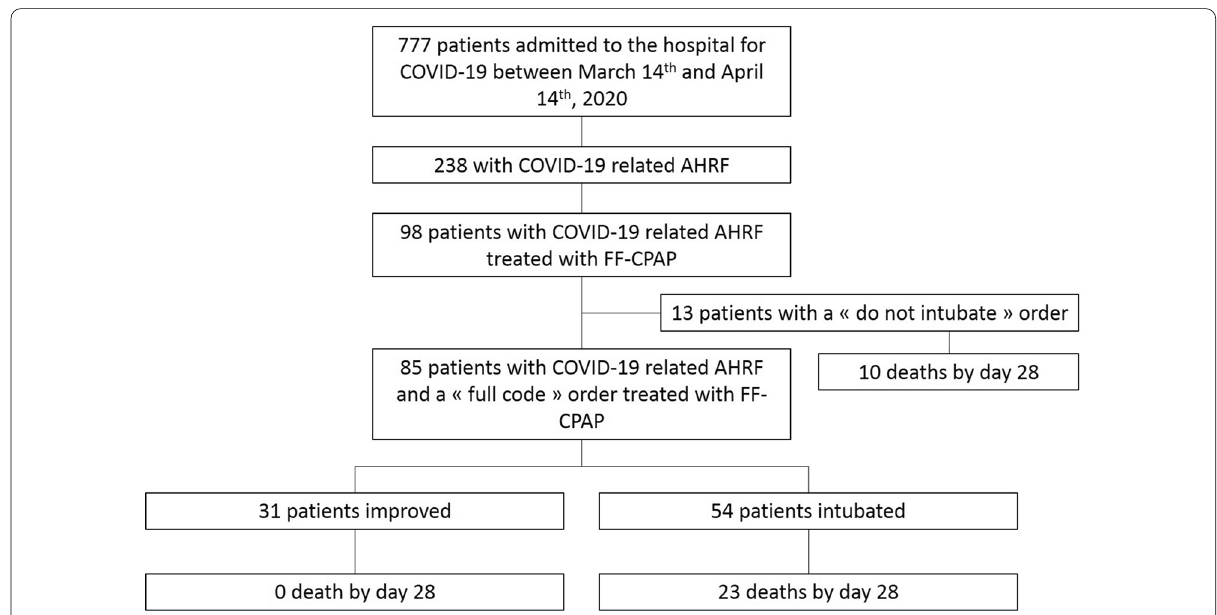
Fig. 3 Clinical study. Flowchart of the study. COVID‑19‑related AHRF was defined as acute dyspnea (with a respiratory rate > 25 breaths/min and/ or active contraction of accessory respiratory muscles), with escalating oxygen therapy SpO 2 > 90%, and new pulmonary infiltrates on chest X‑rays [5] in a patient diagnosed with COVID‑19. FF-CPAP filter frugal continuous positive airway pressure (see text for